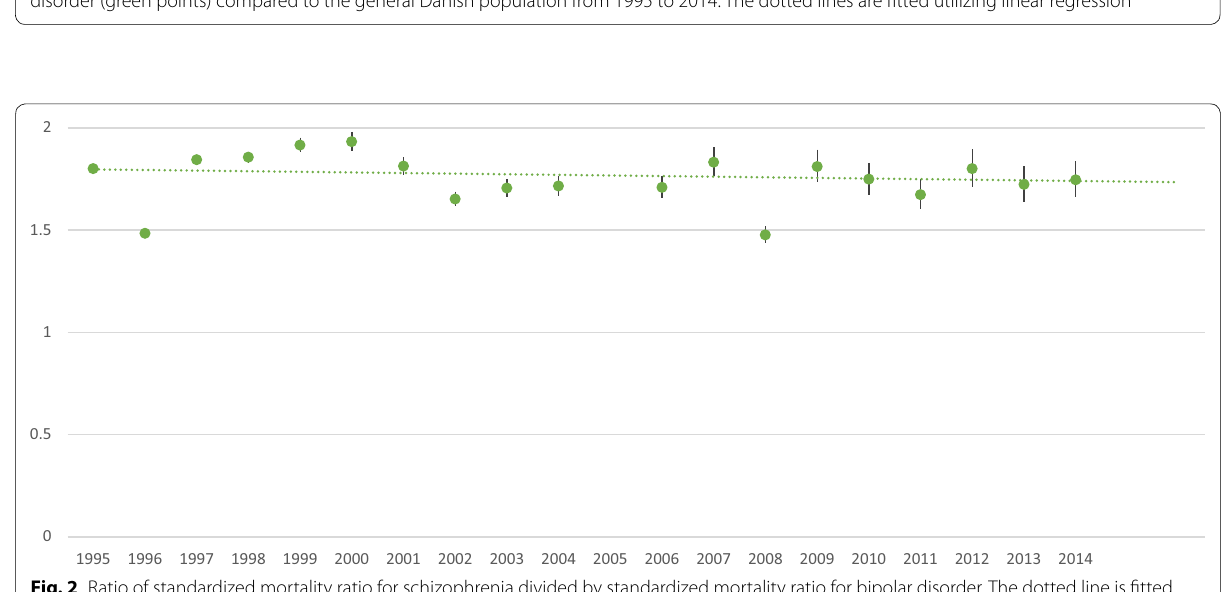
Fig. 1 Standardized mortality ratios including 95% confidence intervals for patients diagnosed with schizophrenia (yellow points) and bipolar disorder (green points) compared to the general Danish population from 1995 to 2014. The dotted lines are fitted utilizing linear regression